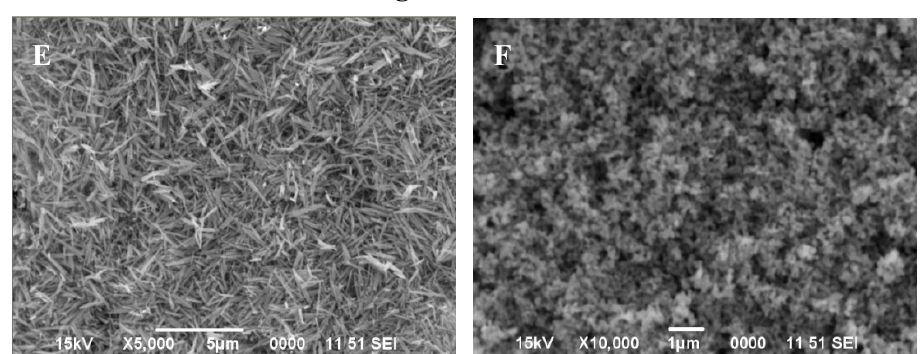
Table 1. Preparation conditions for the particles displayed in various figures. Figure Preparation Conditions Aqueous solution, containing 0.4 mol/L urea and 0.035 mol/L zinc nitrate, and Figure 1(A) 10 vol.% ethylene glycol was heated for 45 min. at 80 °C. Aqueous solution, containing 0.4 mol/L urea and 0.035 mol/L zinc nitrate, and Figure 1(B) 10 vol.% ethylene glycol was heated for 45 min. at 95 °C. Figure 2(A,B) Aqueous solution, containing 0.4 mol/L urea, 0.035 mol/L zinc nitrate and 10 vol.% ethylene glycol was boiled under reflux for 50 min. Figure 2(C) Aqueous solution, containing 0.4 mol/L urea, 0.035 mol/L zinc nitrate and 10 vol. % ethylene glycol was boiled under reflux for 20 min. Figure 2(D) Boiling of solution obtained from 2C under reflux for 30 min. Figure 3(A,B) Aqueous solution, containing 0.4 mol/L urea, 0.035 mol/L zinc nitrate was boiled under reflux for 50 min. Figure 3(C) Aqueous solution, containing 0.4 mol/L urea, 0.035 mol/L zinc nitrate was boiled under reflux for 20 min. Figure 3(D) Boiling of solution obtained from 3C under reflux for 30 min. Figure 4(A) Reflux boiling of aqueous solution containing 0.035 mol/L zinc nitrate and 0.17 mol/L urea for 20 min. Figure 4(B) Reflux boiling of aqueous solution containing 0.035 mol/L zinc nitrate and 0.17 mol/L urea for 5 min. Figure 5(A) Reflux boiling of aqueous solution containing 0.034 mol/L zinc nitrate and 0.013 mol/L hexamine for 40 min. with 4.5 vol.% ethylene glycol. Figure 5(B) Reflux boiling of aqueous solution containing 0.034 mol/L zinc nitrate and 0.013 mol/L hexamine for 40 min. with 4.5 vol.% ethanol. Figure 6(A) Reflux boiling of aqueous solutions containing 0.2 mol/L urea, and 0.03 mol/L zinc nitrate for 30 min. Figure 6(B) Reflux boiling of aqueous solutions containing 0.4 mol/L urea, and 0.03 mol/L zinc nitrate for 30 min. Figure 6(C) Reflux boiling of aqueous solutions containing 0.4 mol/L urea and 0.03 mol/L zinc nitrate, with 15 vol.% ethylene glycol for 30 min. Figure 6(D) Reflux boiling of aqueous solutions containing 0.4 mol/L urea and 0.03 mol/L zinc nitrate, with 4 vol.% ethylene glycol for 30 min. Figure 6(E) Reflux boiling of aqueous solutions containing 0.4 mol/L urea and 0.015 mol/L zinc nitrate, with 4 vol.% ethylene glycol.for 30 min. Figure 6(F) Particles obtained by calcining the particles in 6D at 700 °C for 1 h (heating rate: 15°/min.) Figure 9(A) Zinc oxide particles obtained by calcining zinc basic carbonate 1B at 700 °C for 1